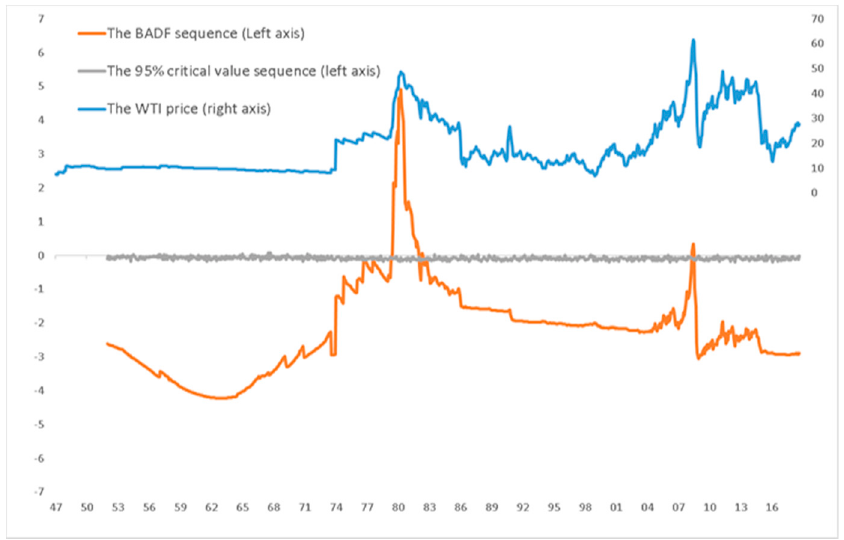
Figure 2. Date-Stamping Explosive periods in the West Texas Intermediate (WTI) prices: the SADF Test, Author’s calculations.